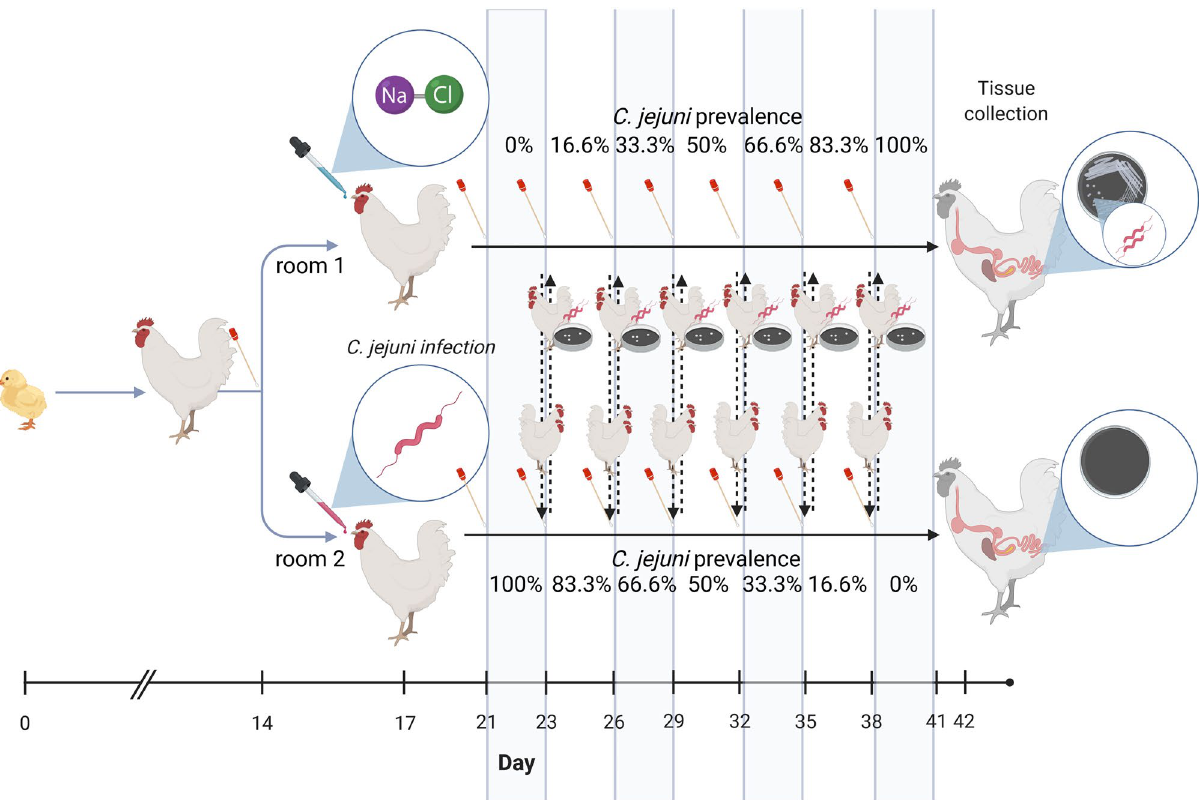
Figure 2. Experimental timeline. At day 14, a total of 24 birds were divided in two groups and kept in two different rooms. All birds prior to the experimental challenge were confirmed Campylobacter -negative via qualitative bacteriological examination of cloacal swabs. At the same day of life, day 17, each of the 12 birds kept in room 2 was experimentally challenged with C. jejuni, while all birds in room 1 received 1 ml of an isotonic 0.9% sodium chloride solution. Three days later, the success of the experimental infection was checked via qualitative detection of C. jejuni in cloacal swabs of all experimentally infected birds, so that at day 21, the experimental phase started and lasted for 21 days. Within these 21 days, a cloacal swab was obtained from each chicken every three days for qualitative detection of C. jejuni . Additionally, a quantitative bacteriological examination of C. jejuni was performed in excreta samples of the two birds in room 2 that subsequently changed rooms. The experiment ended at day 41 of life. Birds were dissected one day later to obtain caecal contents for qualitative detection of C. jejuni . The figure was created with http:// biore nder.